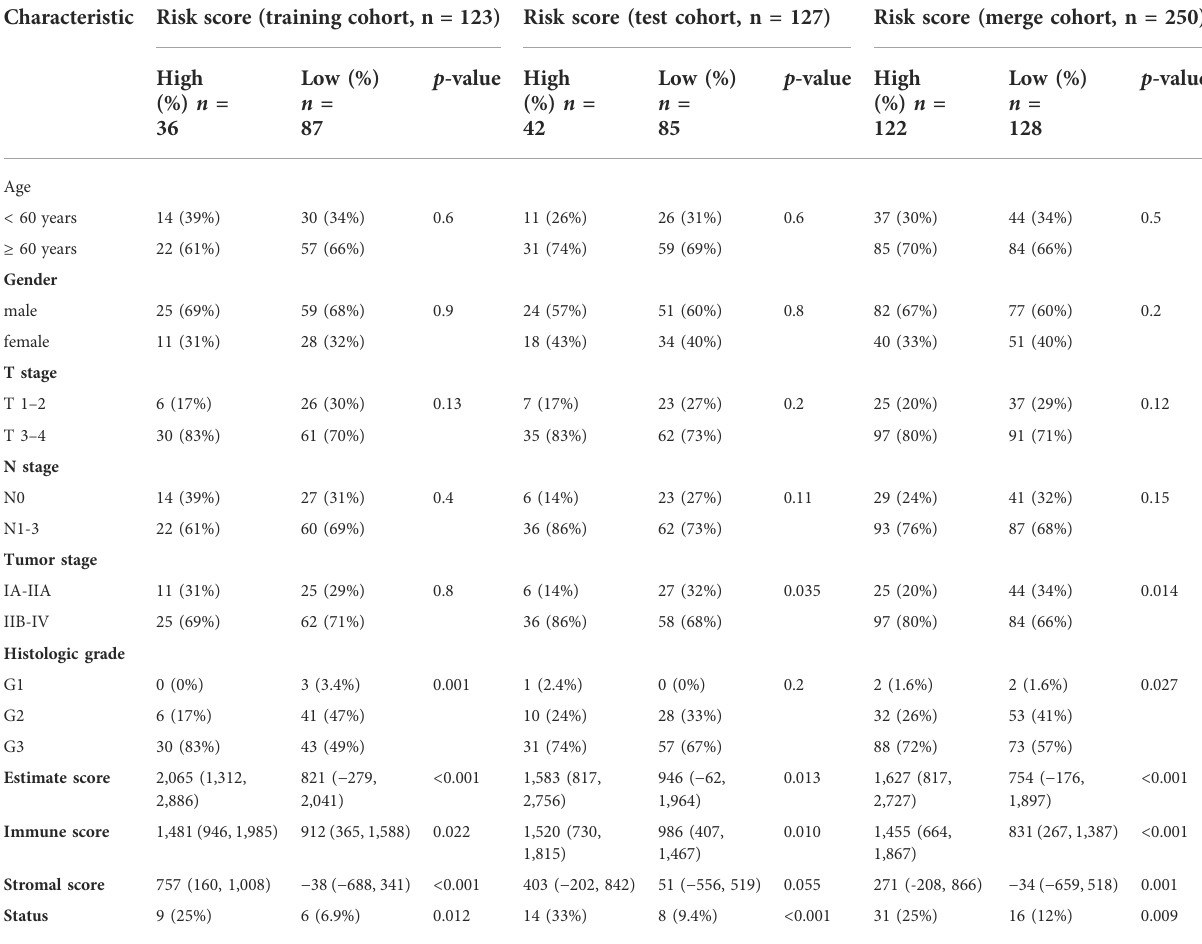
TABLE 1 Correlations between risk score and clinicopathologic characteristics of GC